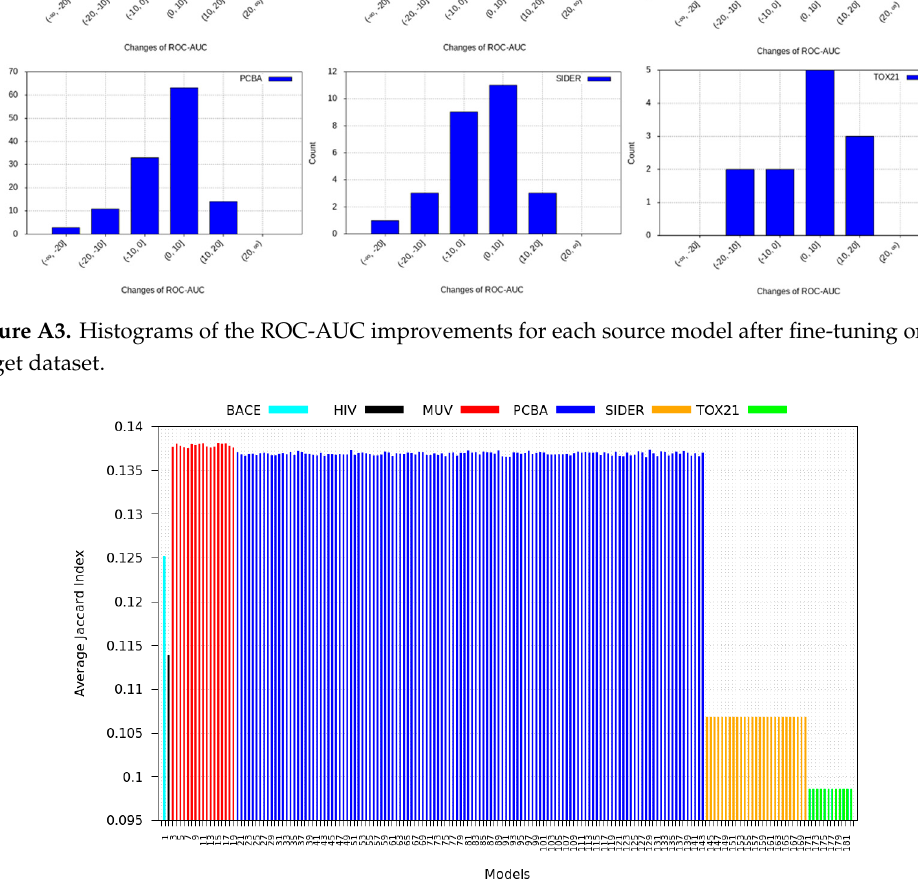
Figure A4. Detailed similarity of each source dataset to the target dataset.